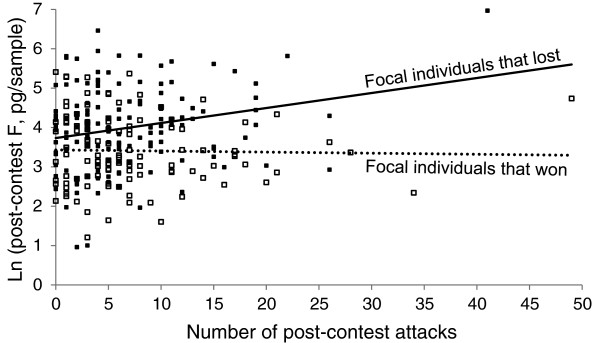
The influence of post-contest attacks on post-contest F levels. Post-contest F levels (ln transformed) for the focal individuals that won (clear squares) and lost (filled squares) to their size-matched opponents, where winners delivered different numbers of post-retreat attacks to the losers. The broken line shows the relationship between the focal individuals’ post-contest F levels and the number of attacks they delivered to their defeated opponents (for the focal individuals that won), and the solid line shows the relationship between the focal individuals’ post-contest F levels and the number of attacks they received from their victorious opponents (for the focal individuals that lost).